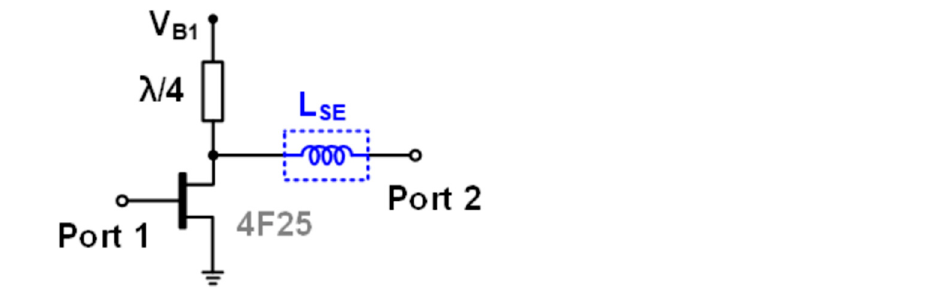
Figure 3. Common source single stage (4F25) adopting series inductor ‐ based stability enhancement technique.